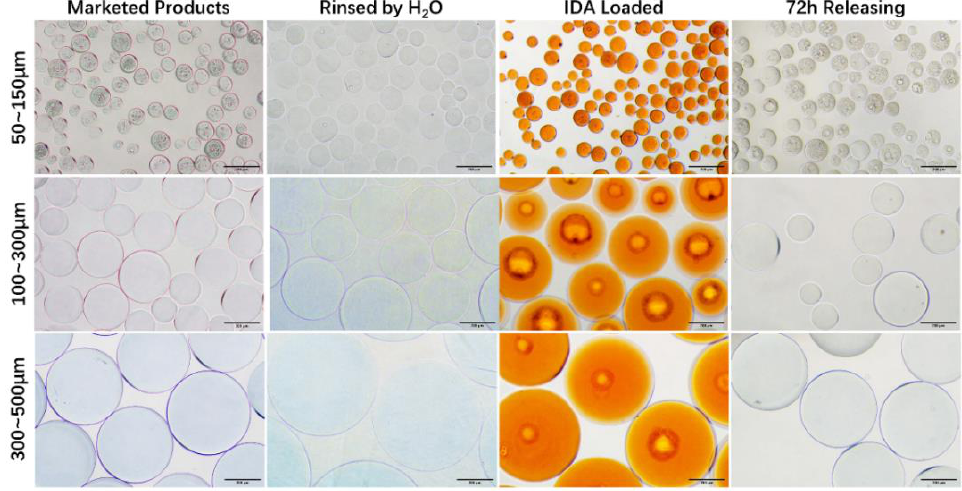
Figure 4. Optical microscope images of CalliSpheres ® before/after IDA loading and release. Scale bars: 200 μm.